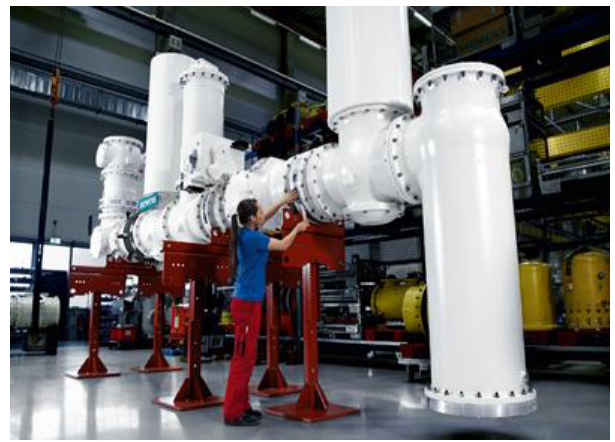
Figure 15. Siemens’ first compact ±320 kV HVDC GIS [65].